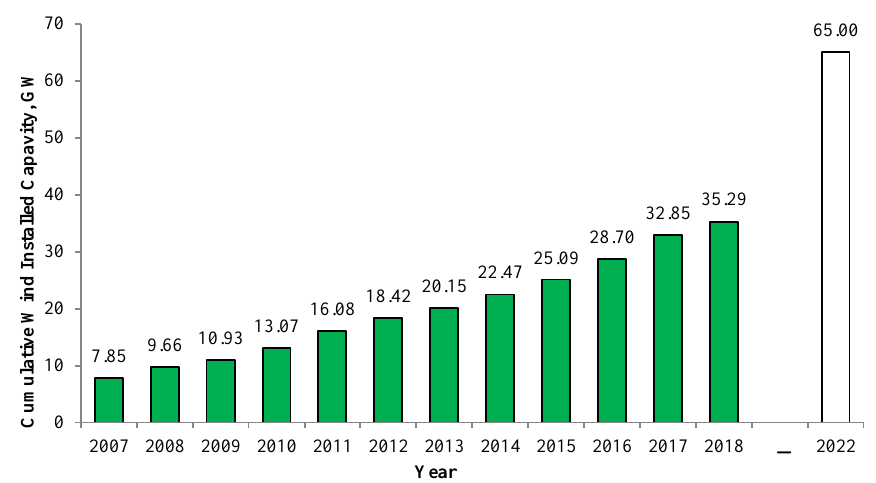
Fig. 1. Cumulative wind power installed capacity in India over the years (2007–2018) and the year 2022 target [24], [25].